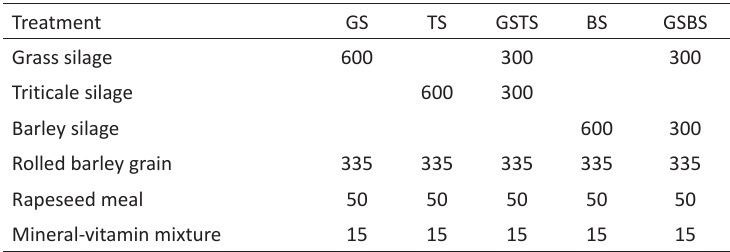
Table 1. The proportion (g kg -1 dry matter) of the feeds in the experimental diets